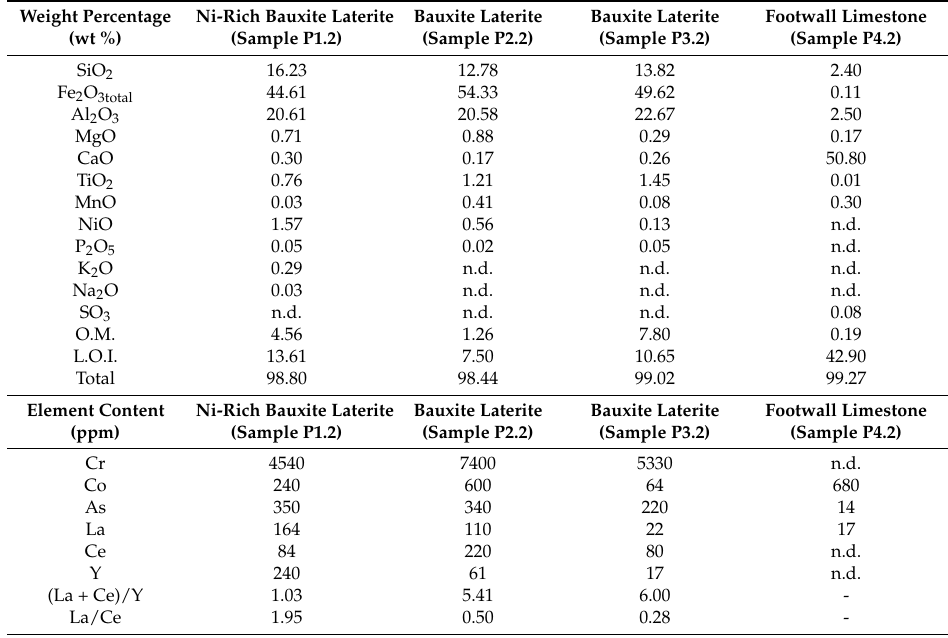
Table 2. Chemical composition of the bauxite laterites from the Patitira Profile I. O.M.: organic matter; L.O.I.: Loss on ignition; n.d.: not detected. Weight Percentage (wt %)